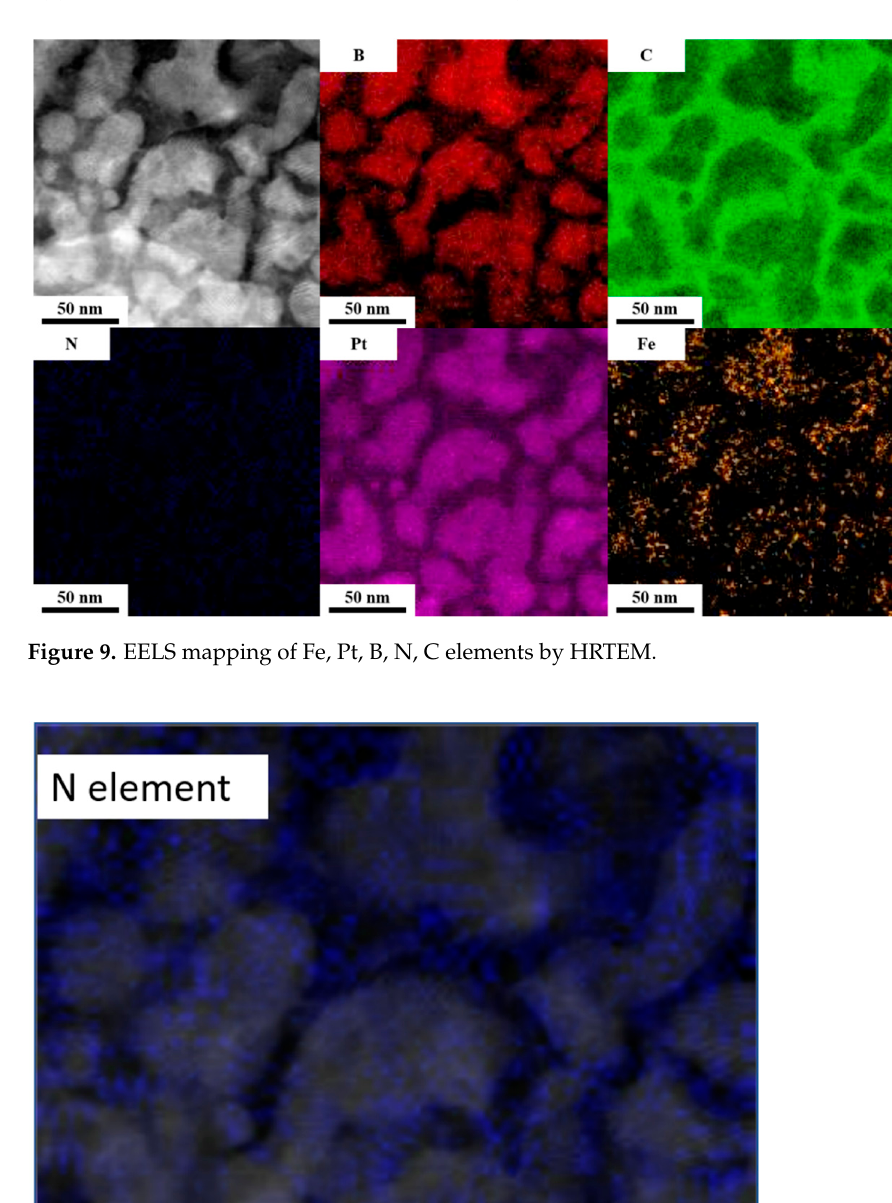
Figure 10. EELS mapping of grains image and N elements (indigo color).